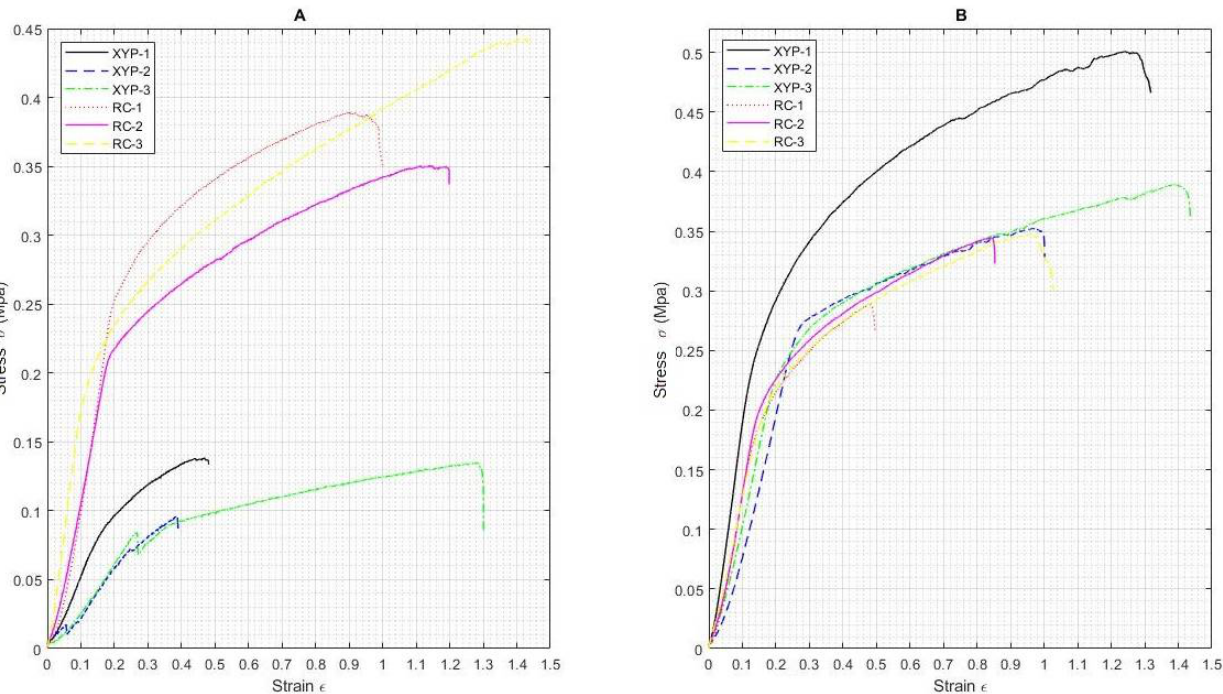
Figure 3. Stress-strain curves of PCL scaffolds obtained using RC and XYP. ( A ) Deposition time: 45 min, ( B ) deposition time: 90 min.